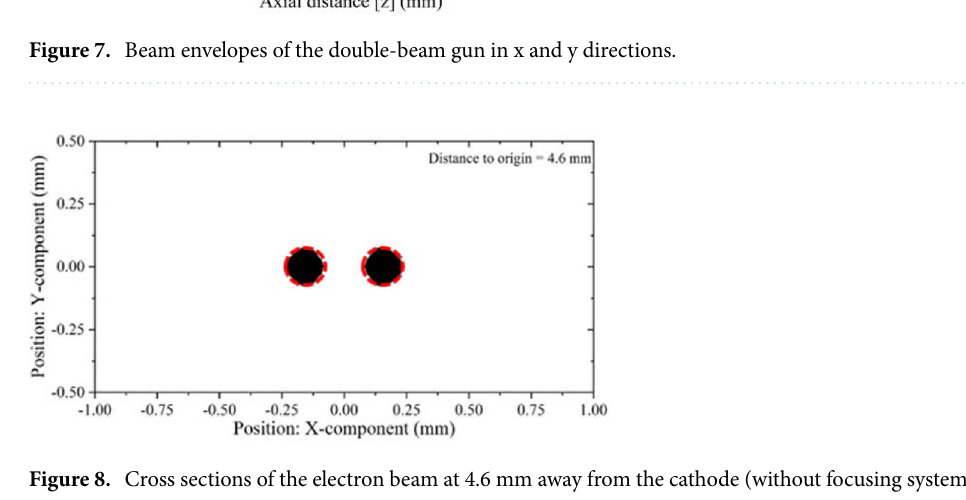
Figure 8. Cross sections of the electron beam at 4.6 mm away from the cathode (without focusing system).